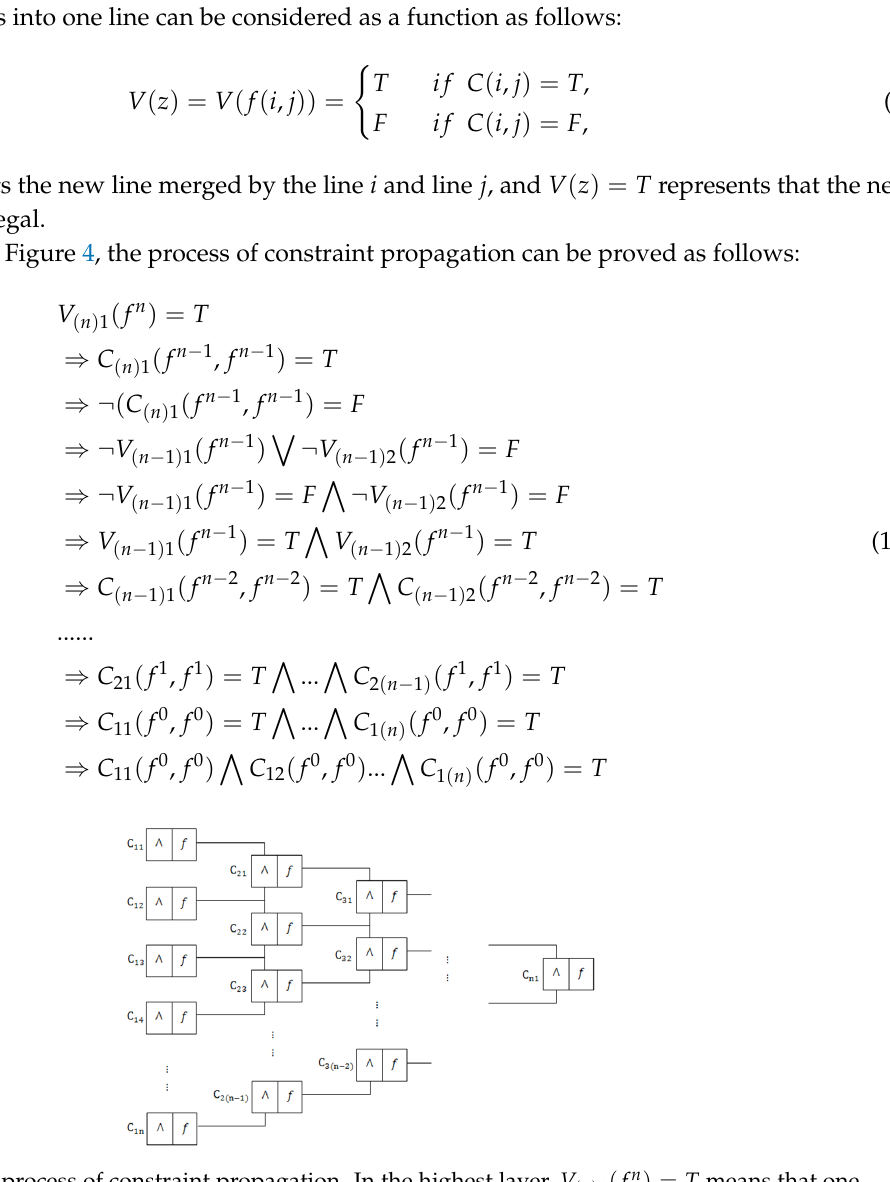
Figure 4. The process of constraint propagation. In the highest layer, V ( n ) 1 ( f n ) = T means that one line in this layer represents a combination of basic lines that might satisfy the geometric constraints in C 11 ∼ C 1 ( n ) . C 1 n means the n constraint in the first layer. Λ means two lines satisfy the geometric constraint. f means two lines that satisfy the constraint are merged into a new line. By constraint propagation, it is possible to efficiently detect lines that satisfy the first layer constraints C 11 ∼ C 1 ( n )